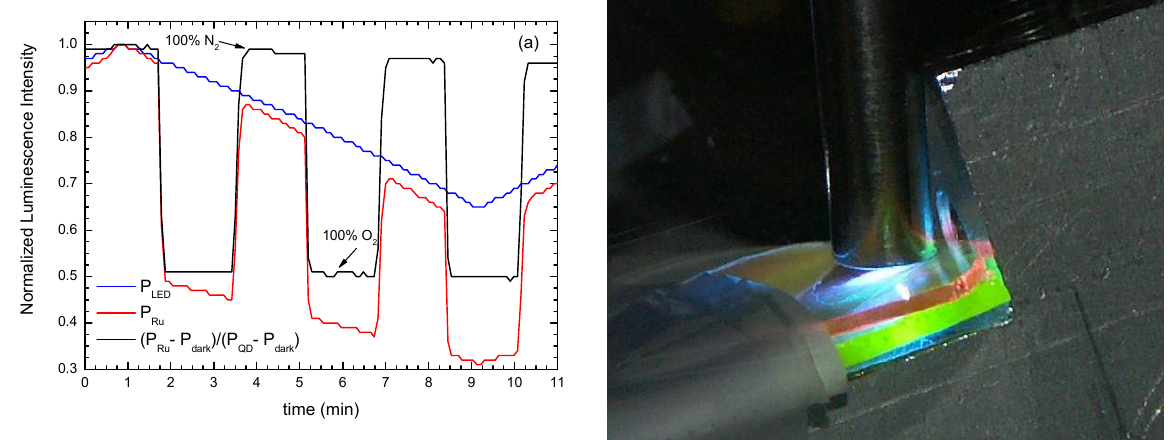
Figure 11. a) Sensor response to O